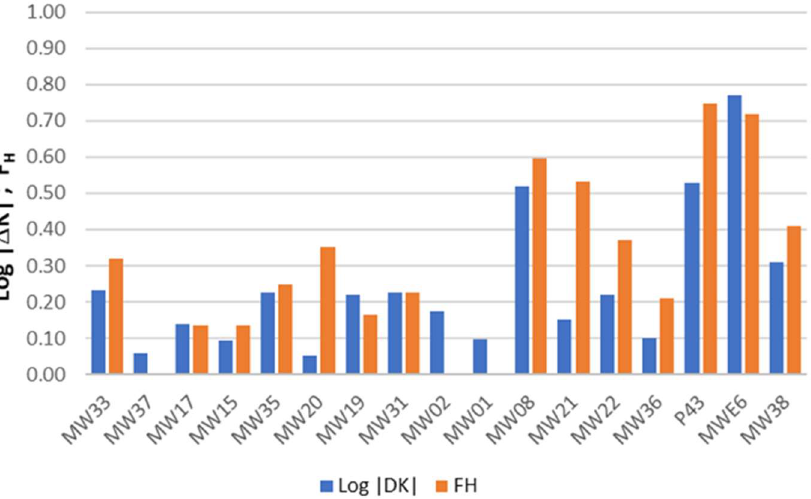
Figure 12. Graphical comparison between horizontal hydraulic conductivity precision and the proposed heterogeneity factor F H for each monitoring well.